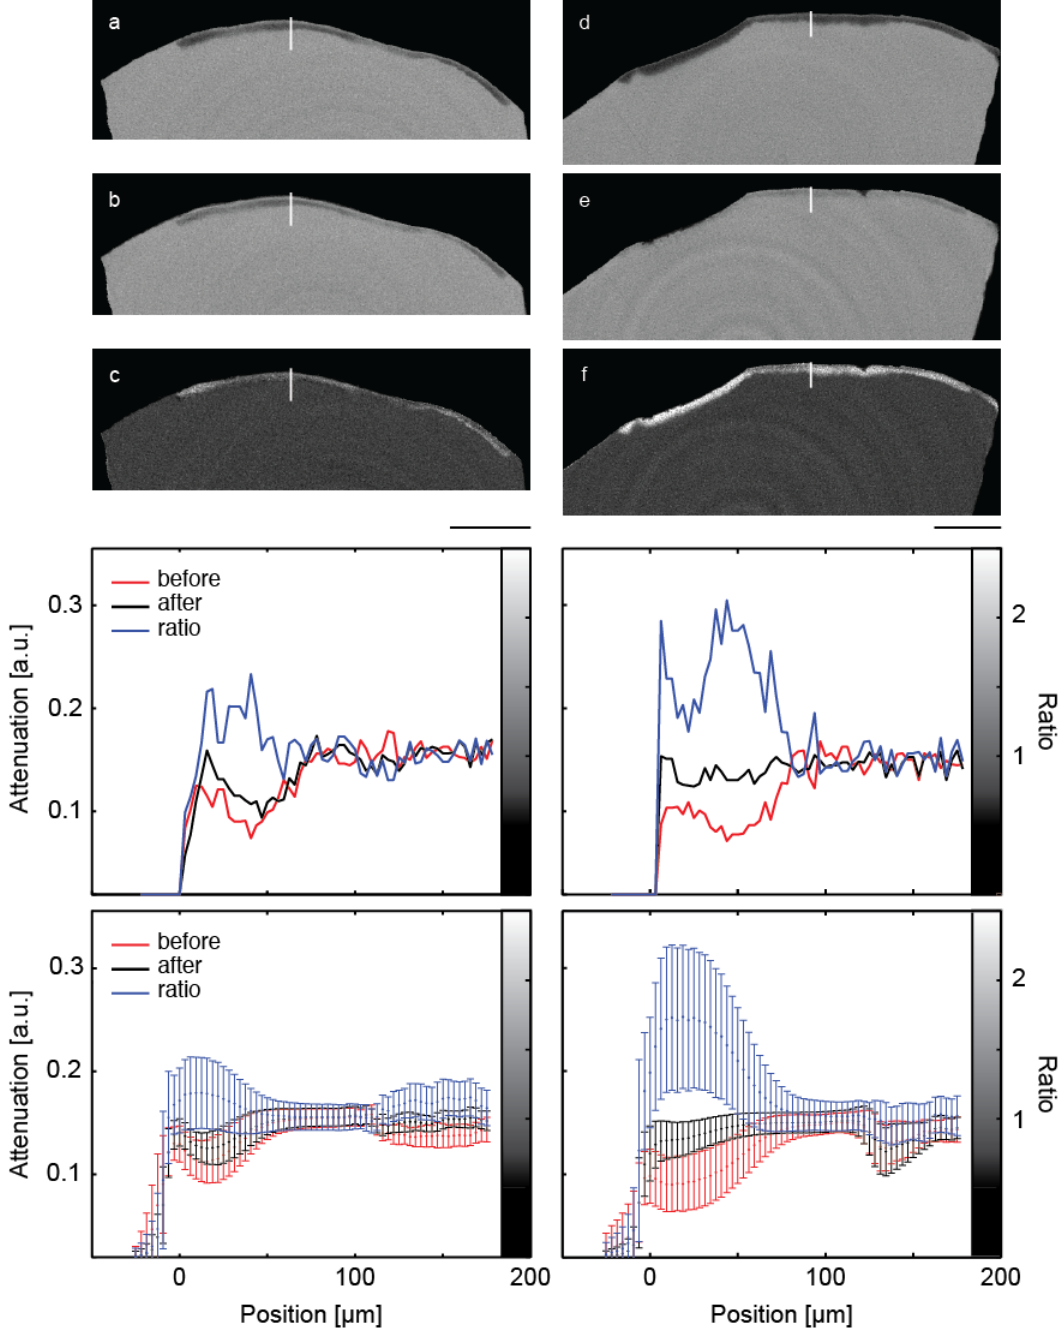
Figure 2. The images show selected slices of the μCT-data from the two pieces of the crown through the induced lesions. The images ( a ) and ( d ) are obtained before treatment. The related slices of the μCT-data after the treatment are images ( b ) and ( e ), ( b ) being the control and ( e ) the specimen treated with the peptide. Images ( c ) and ( f ) show the ratio of the attenuation values. The length bar corresponds to 500 μm. The diagrams in the central row show selected line plots through the lesion with locations indicated by the white lines in the images above. The increased mineral content caused by the mineralization treatments is clearly indicated. In the diagrams in the bottom row, the attenuation in the lesions is plotted against the distance from the specimen surface, integrated over the entire specimen. Error bars correspond to the standard